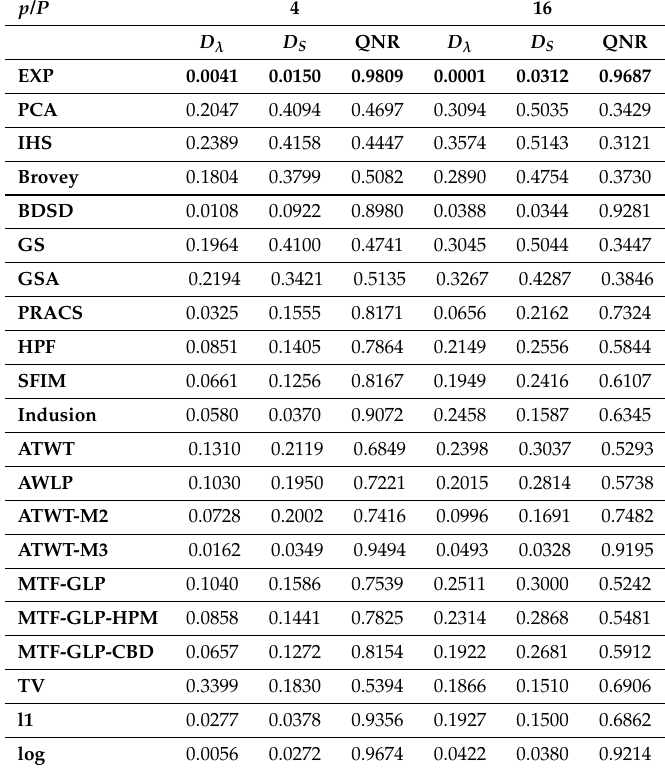
Table 11. QNR Quantitative results on the SPOT-5 Roma image. Bold values indicate the best